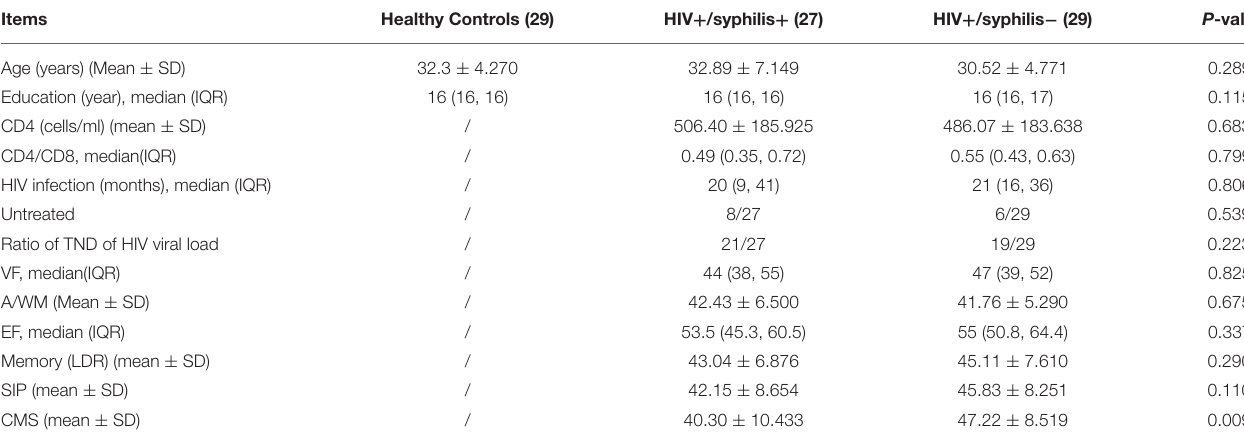
HIV + /Syphilis + , HIV-infected patients with current syphilis or a history of syphilis; HIV + /syphilis–, HIV-infected patients without syphilis co-infection history; TND, target not detected, HIV viral load < 40 copies/ml; VF, verbal fluency; A/WM, attention/working memory; EF, executive function; SIP, speed of information processing; LDR, learning/delayed recall; CMS, complex motor skills. a Kruskal–Wallis